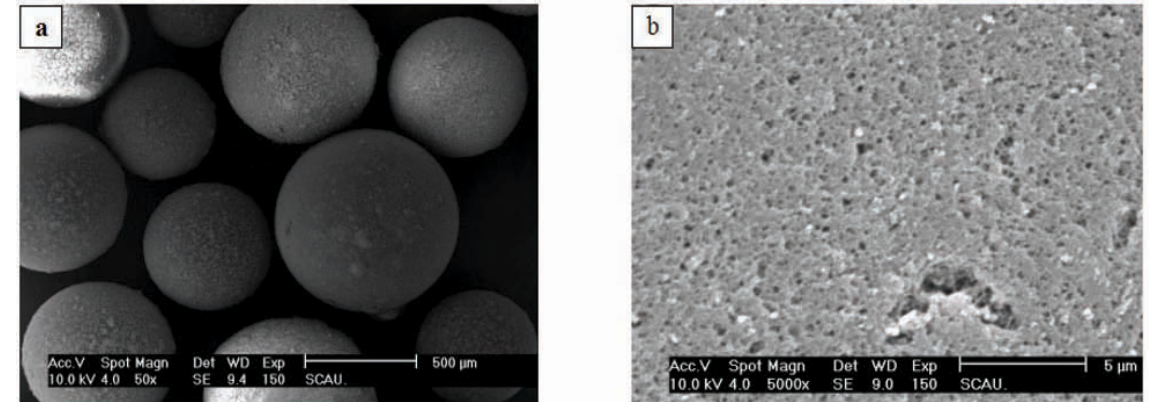
Figure 1. SEM images of magnetic porous γ -Fe